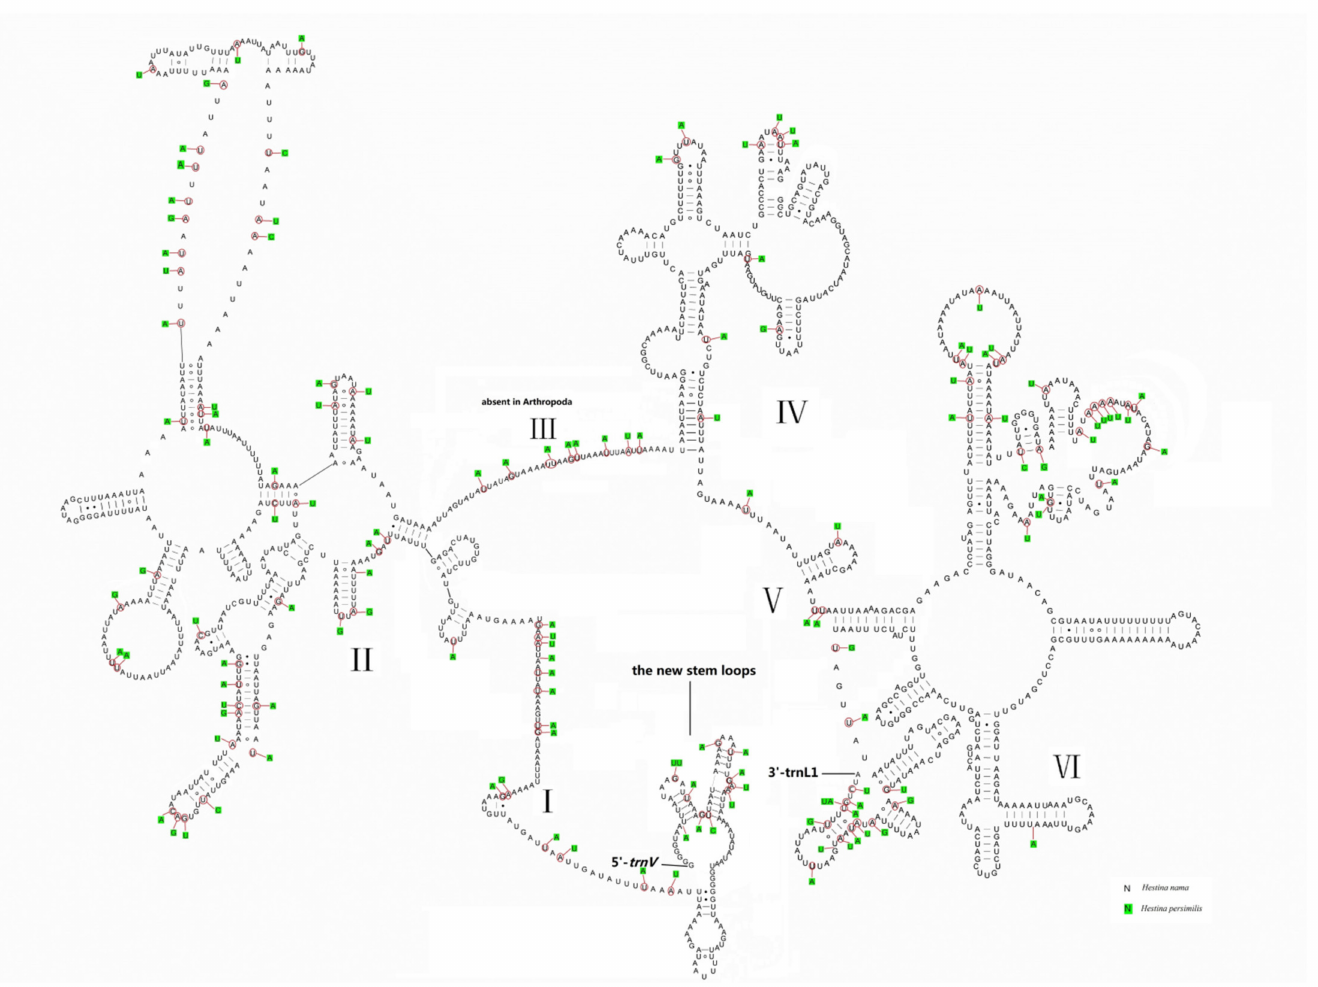
Figure 6. Predicted rrnL secondary structure of Hestina persimilis and Hestinalis nama mitogenomes. Dashes, black dots and circles indicate the Watson-Crick base pairings, G-U bonds and U-U, A-A, A-C and A-G bonds,